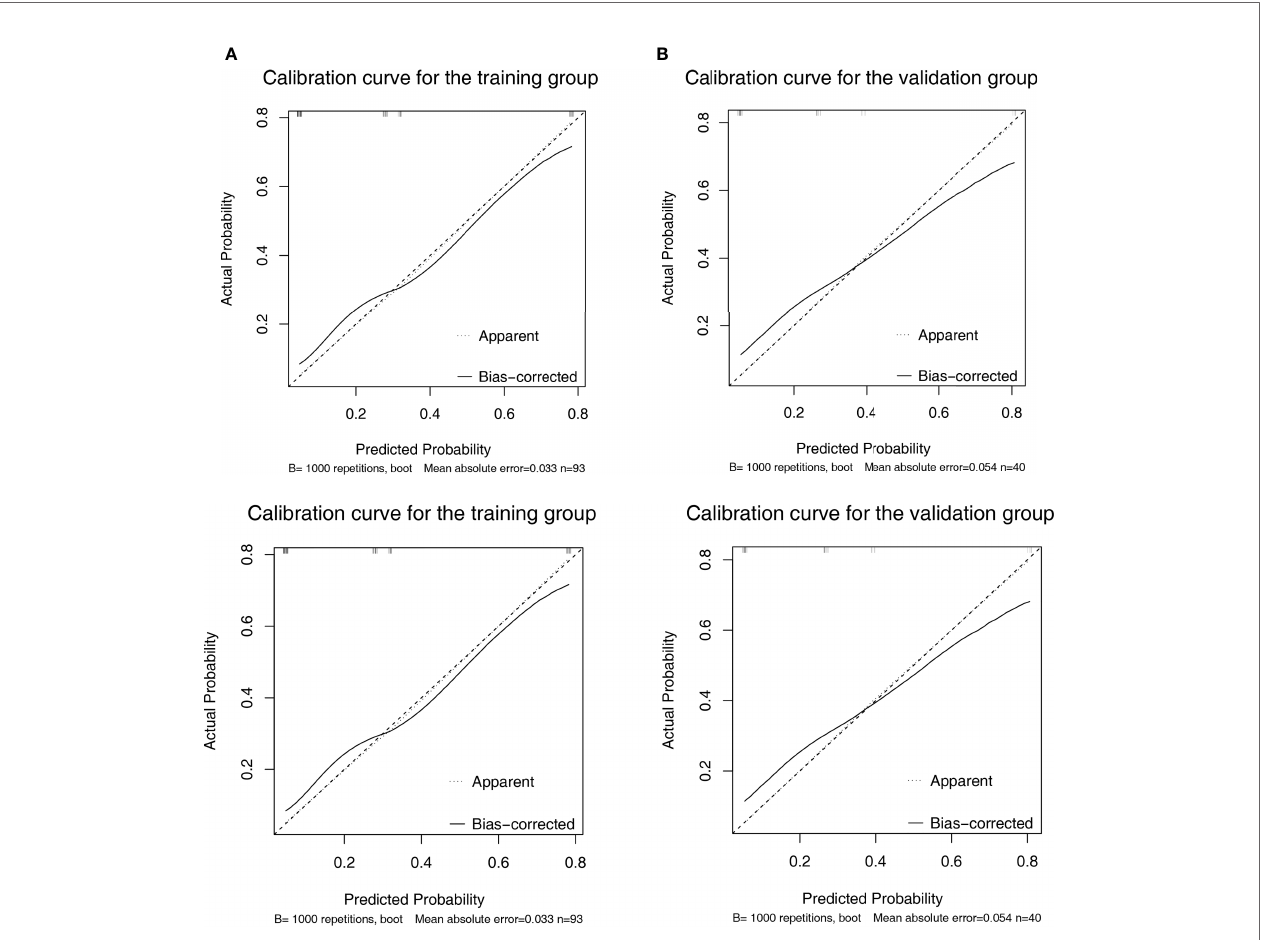
FIGURE 4 | Calibration curve of the nomogram in the training (A) and validation (B) set. X-axis represents the nomogram predicted probability of Progressive Diseases (PD). Y-axis represents the actual probability of PD, and the diagonal dashed line (represent ideal) indicates the ideal prediction by a perfect model. Results were plotted via bootstrapping with 1000 resamples. The closer the bias-corrected calibration curve (solid line) is to the diagonal line, the higher the prediction accuracy of the